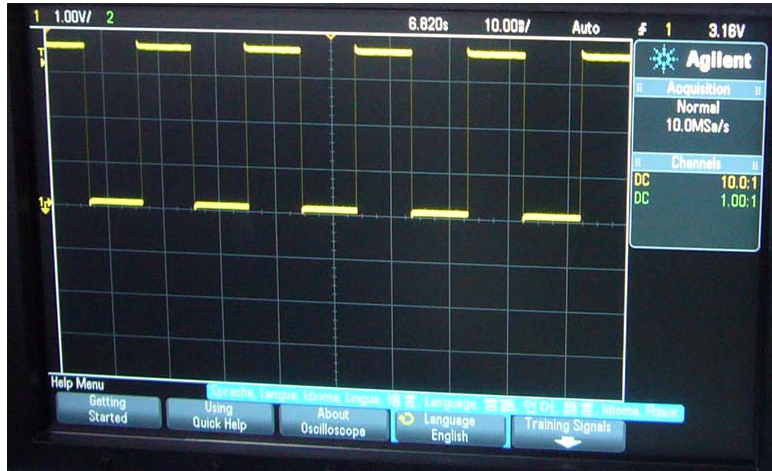
Figure 11. Digital output of the Hall sensor displayed on an Agilent 3032A oscilloscope.